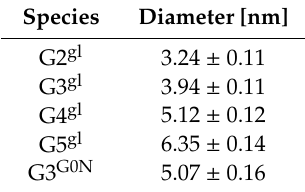
Table A3. Molecular size of GM gl and G3 G02N measured using DLS